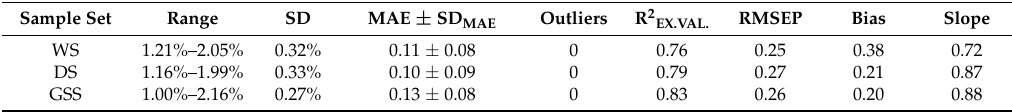
Table 4. External validation of the NIR calibration model for the prediction of TOC in unknown samples of WS, DS and GSS sets. Range and SD refer to NIR predicted values.